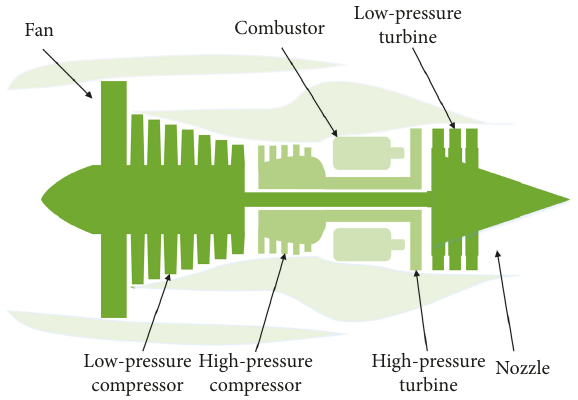
Figure 4: Schematic illustration of an aircraft engine model. Table 1: Six different operation states. Setting parameter State